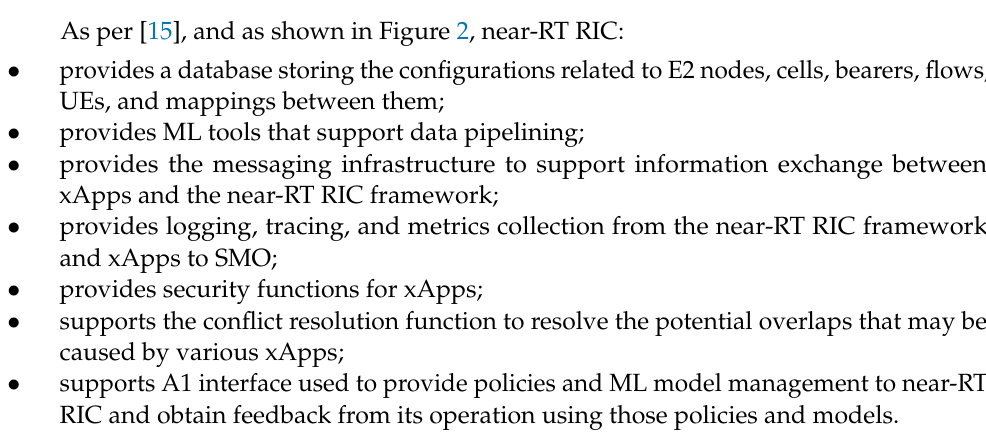
Figure 2. RAN Intelligent Controller: non-RT RIC and near-RT RIC.